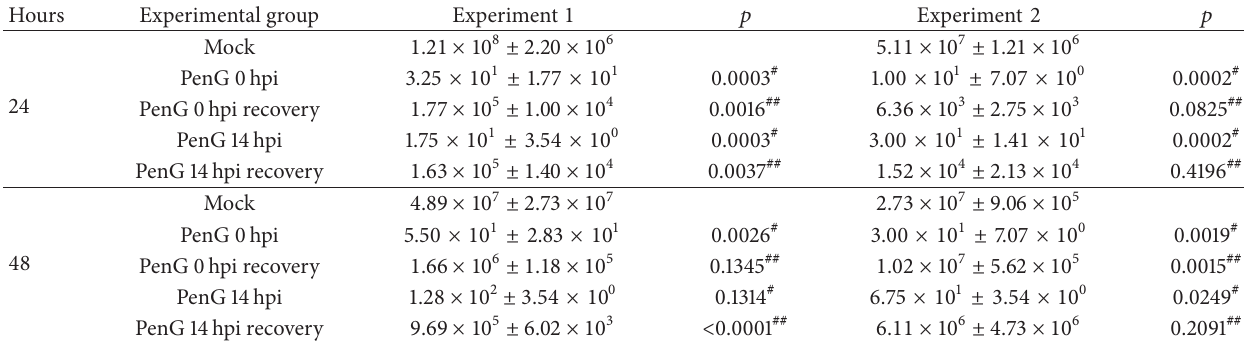
Table 1: Chlamydia pecorum recovers infectious elementary body production (inclusion-forming units/mL) upon discontinuation of penicillin G